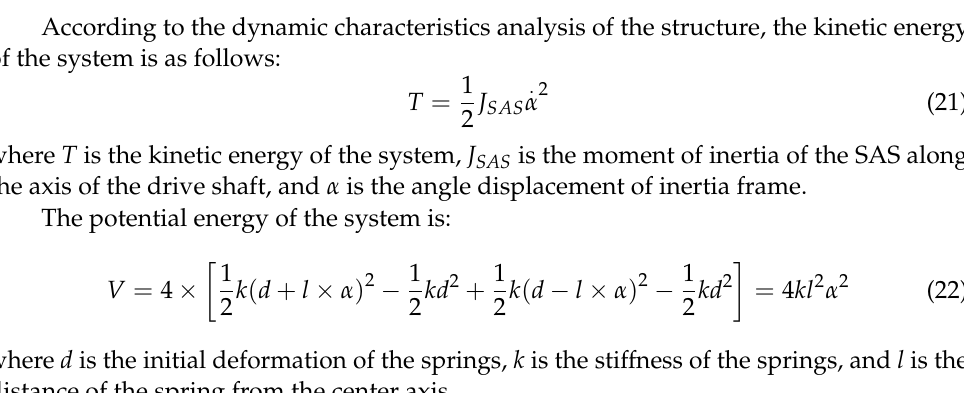
Figure 6. A structure sketch of the SAS.